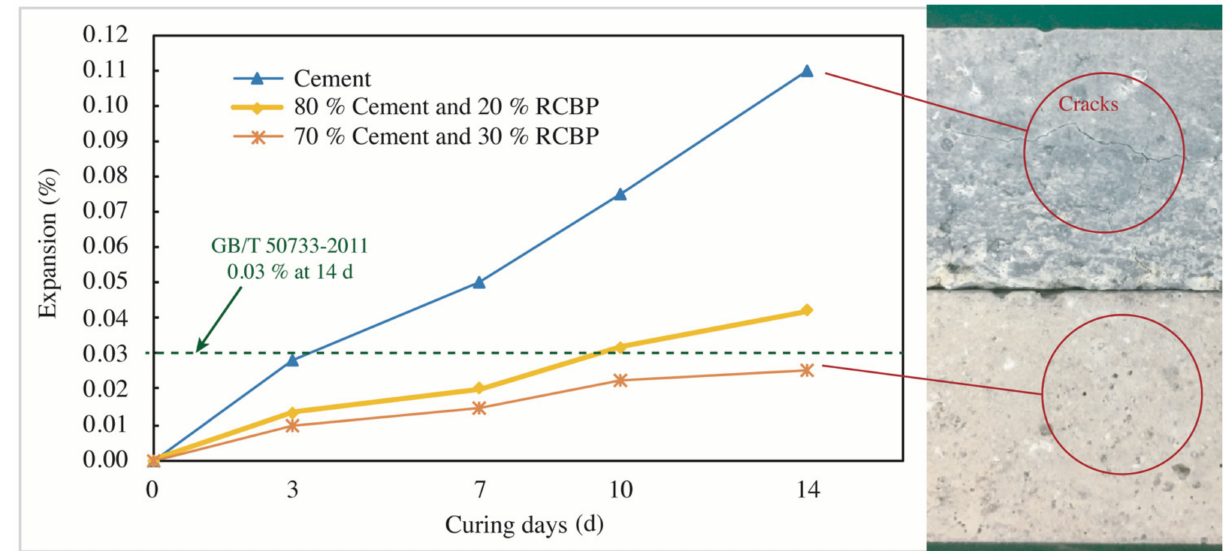
Figure 8. Alkali–silica expansion from RG with and without